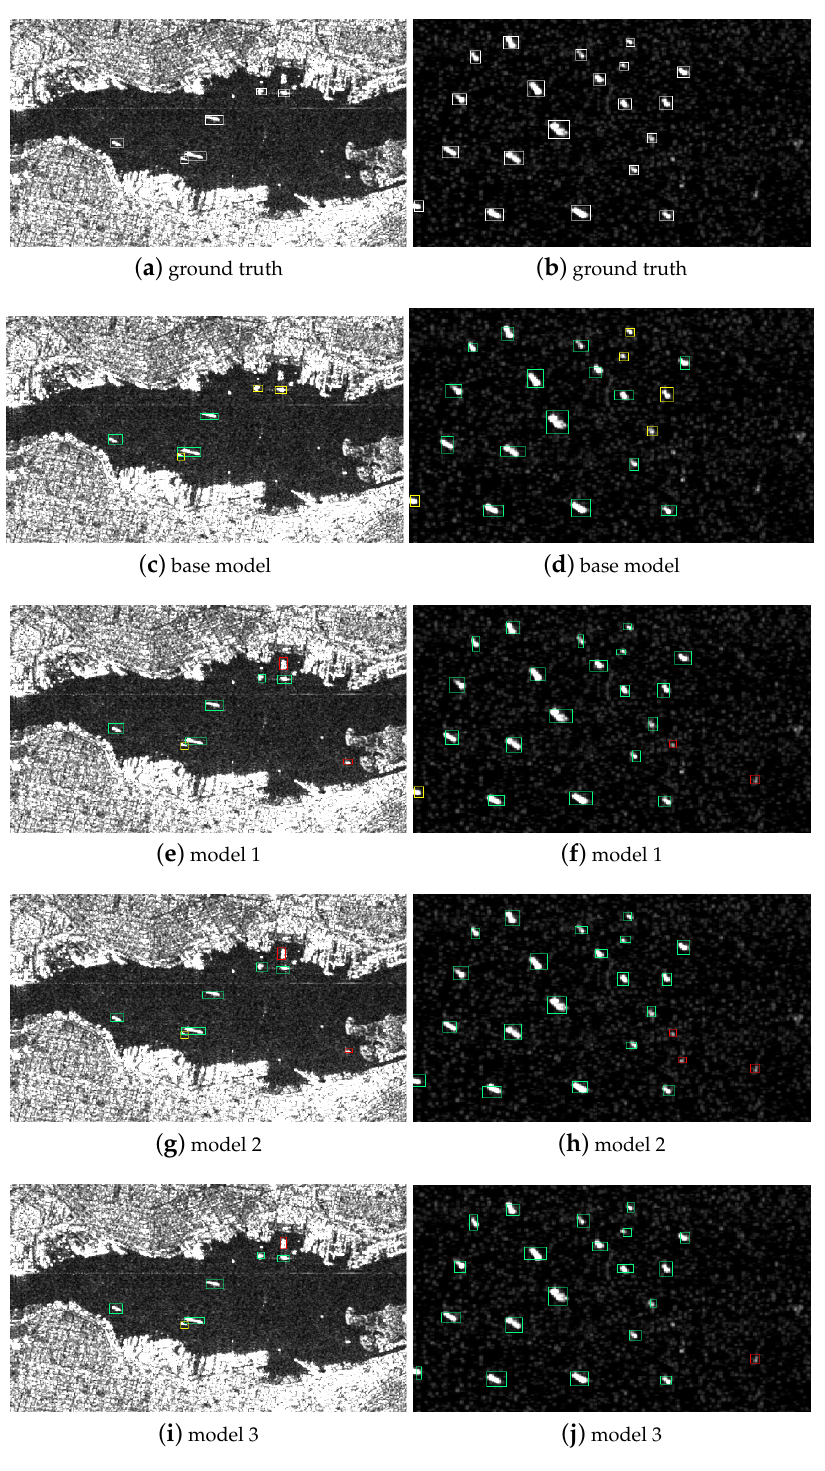
Figure 10. Detection results with different fusion layers. The left row is the SAR image of ships near the shore, the right row is the SAR image of ships in the open sea. The green, red, and yellow rectangles represent the positive detection, false detection, and missing ships,